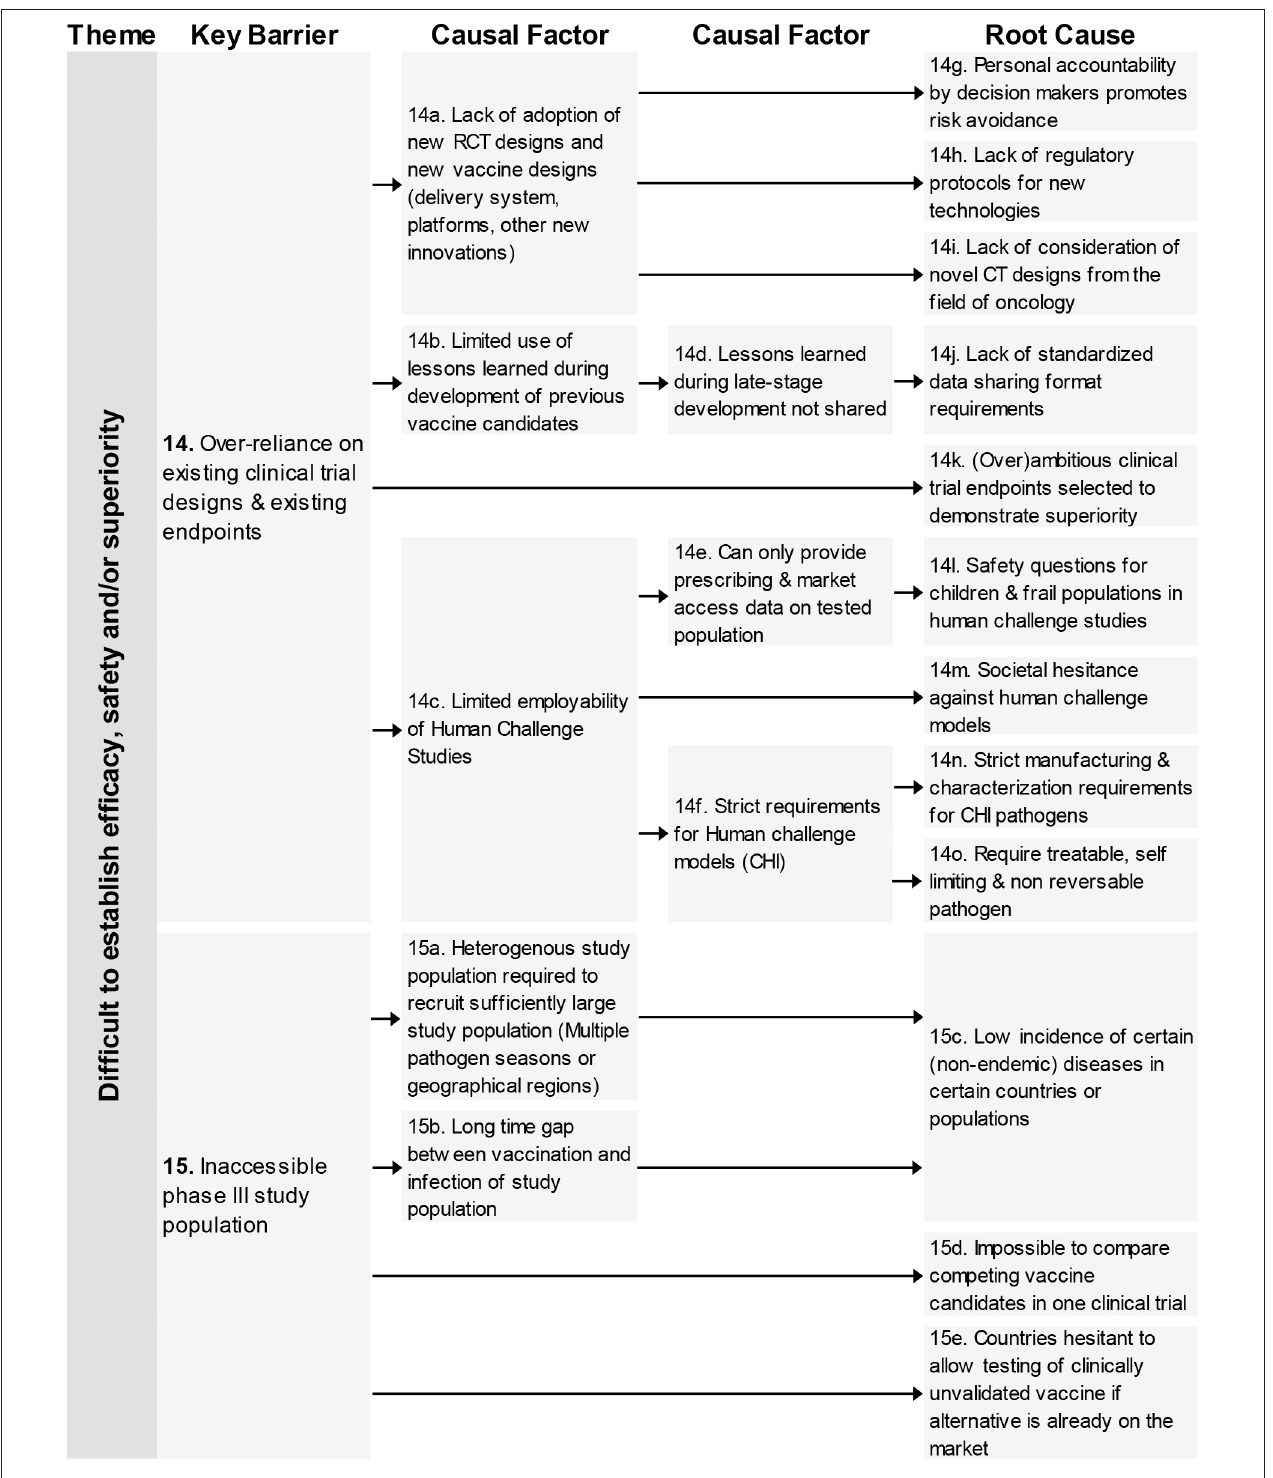
FIGURE 4 | Root-cause analysis (part 2) of the theme “Difficult to establish efficacy, safety, and/or superiority.” Columns are causally structured. (Left) key barriers are listed that are caused by causal factors (middle), which in turn find their origin in root causes (right).